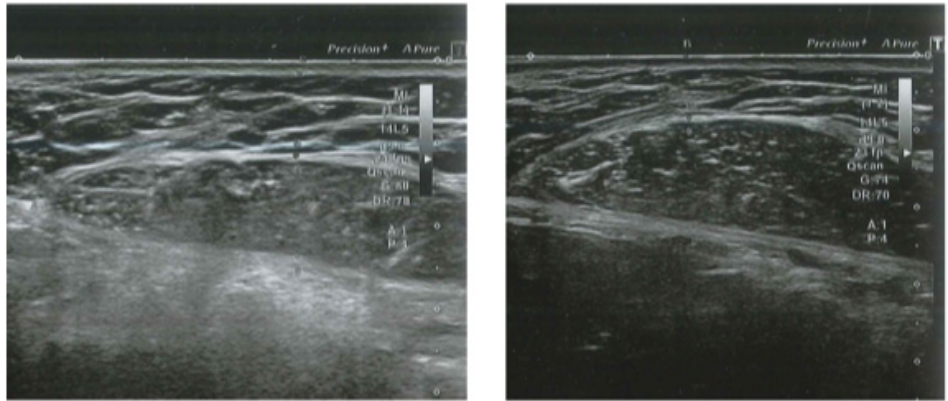
Figure 2. Abdominal echography of a male patient before ( left ) and three months after ( right ) the last treatment. Visible fat reduction and improvement of rectus abdominis muscle thickness in the treated area are observed.